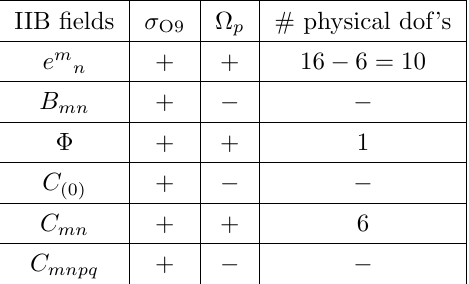
Table 23 . Counting of the total 17 propagating scalar dof’s allowed by O9-planes in type IIB compacti(cid:12)cations down to six dimensions. This is exactly the dimension of the supergravity coset given in (3.1), once we subtract from e m n the 6 unphysical directions corresponding to the compact SO(4) generators.